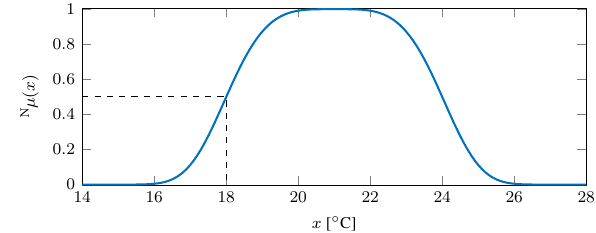
Figure 3. Exemplary membership function for the normal condi- tion of a temperature sensor with x = 21 ◦ C, C = 3 ◦ C, and D = 4. A measurement of x = 18 ◦ C results in a membership of µ ( x ) = 0 . 5, as marked by the dashed